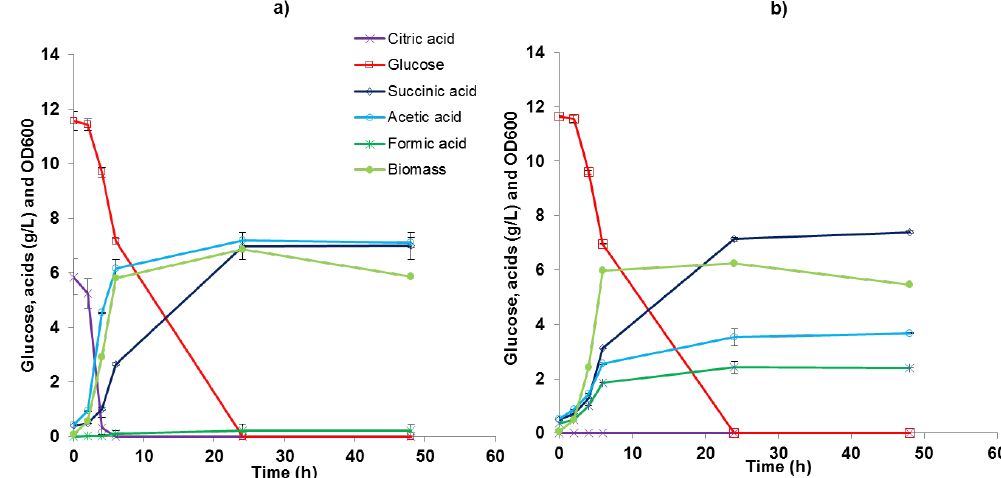
Figure 3. Growth of A. succinogenes in 0.1 L bottle experiments. Experiments were conducted on MH medium with ( a ) and without ( b ) citrate supplementation. Curves indicate consumption of glucose and citrate, and production of acids and biomass.